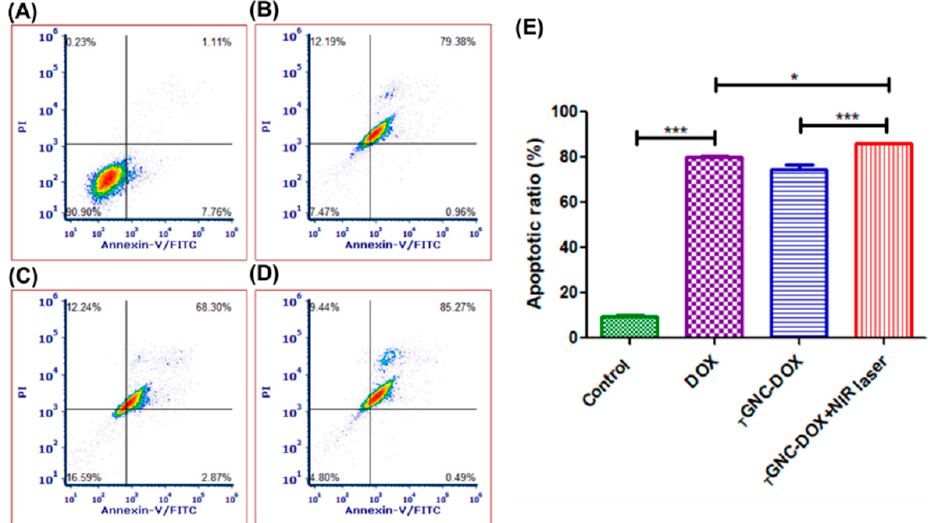
Figure 13. Apoptosis assay followed by treatment of: ( A ) control; ( B ) DOX; ( C ) T GNC-DOX only; ( D ) T GNC-DOX +NIR laser; and ( E ) bar graph of percentage apoptotic ratio of different treatment groups ( n = 3) (*** p < 0.001, * p < 0.05).